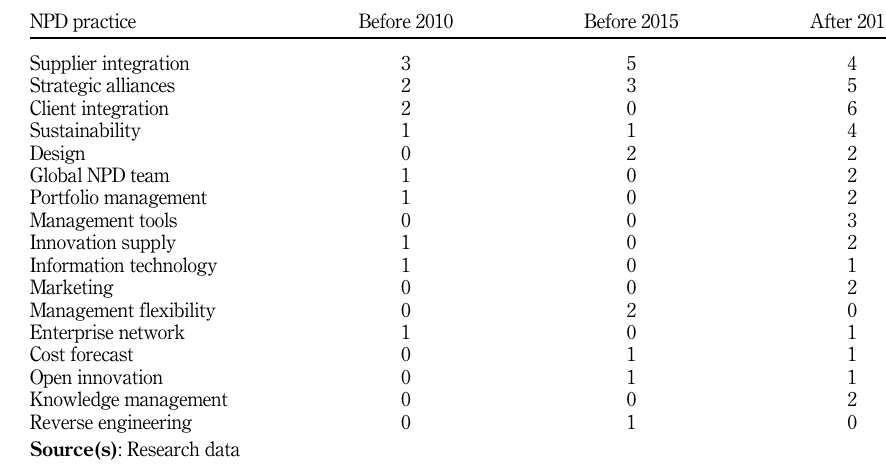
Table 2. NPD practices by